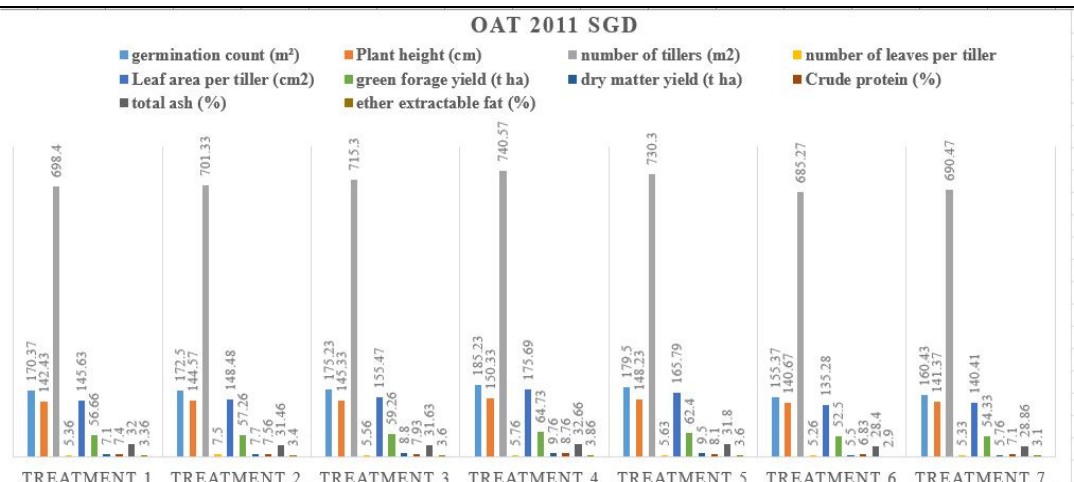
Figure 3. Effect of (INM) on oat cultivar Sargodha 2011 .